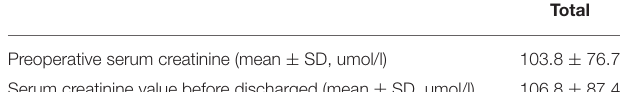
TABLE 2 | Intraoperative data.